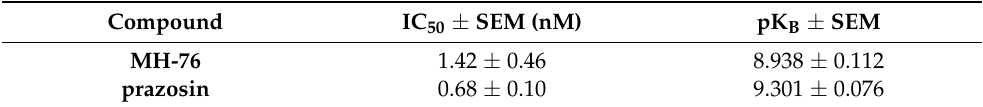
Table 1. Functional activity results for MH-76 and prazosin. Antagonist potency towards α 1A - adrenergic receptors, expressed as half maximal inhibitory concentration-IC 50 (nM), and and negative log of the antagonist dissociation constant-pK B with